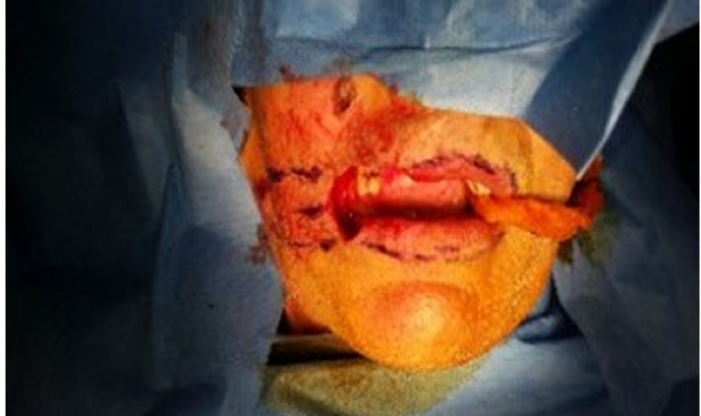
Figure 7. Case 2: excision and reconstructive planning.